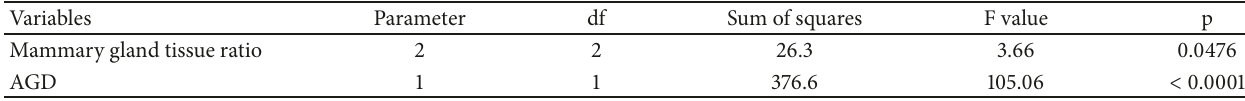
Table 2: Results of the multivariate analysis for effect of mammary gland density and AGD on CNR. Variables Parameter df Sum of squares F value